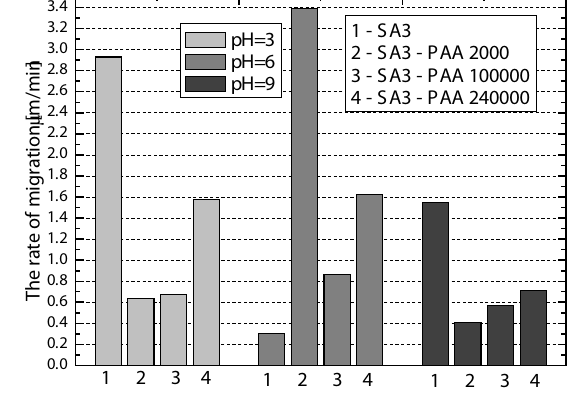
Figure 6. The rate of aggregate (floc) migration in SA 3 suspension in the absence and presence of polyacrylic acid at different solution pH.